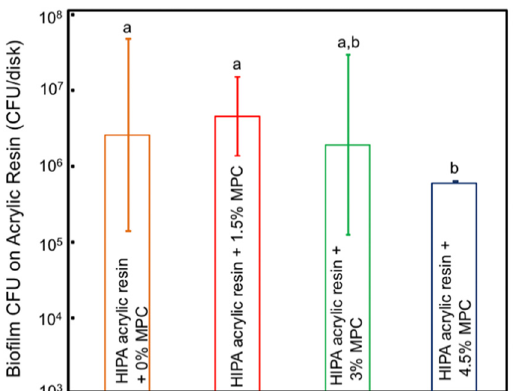
Figure 3. Colony-forming unit (CFU) counts of the C. albicans 2-day biofilm on the HIPA acrylic disks (mean ± SD; n = 4). The experimental group with 4.5% MPC resulted in a significant ( ≅ 1 log) CFU reduction compared to the control group with 0% MPC ( p < 0.05) .